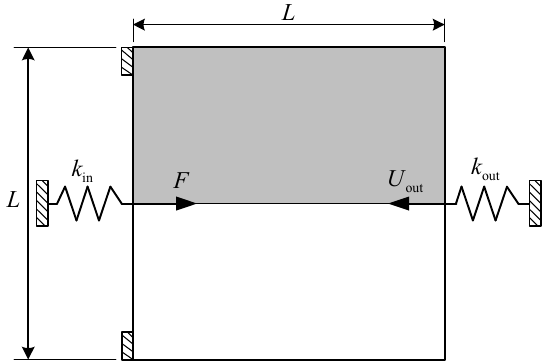
Figure 1. Design domain of compliant inverter.